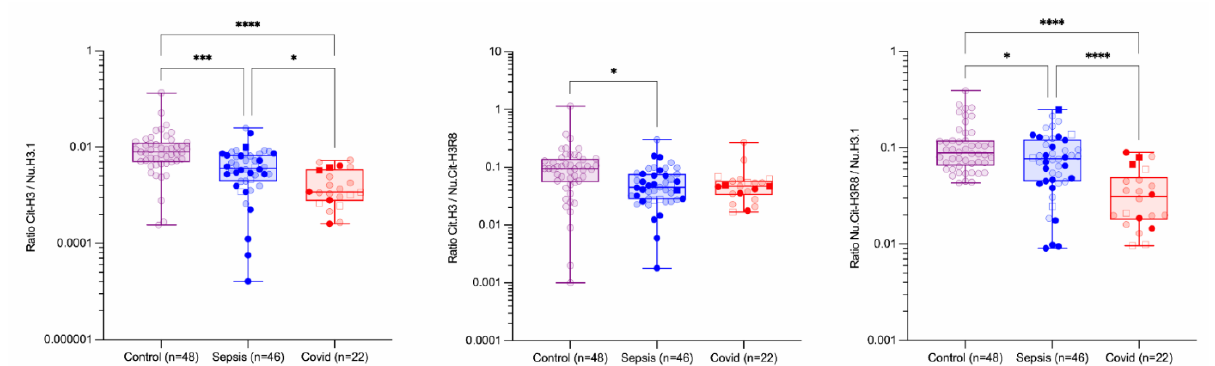
Figure 2. Ratio of circulating nucleosomes and neutrophil activation parameters in control, septic shock and critical COVID-19 subjects. The following ratios were proposed: (i) ratio of Cit-H3 on Nu.H3.1, (ii) ratio of Cit-H3 (citrullinated in R2, R8 and R17) on Nu.Cit-H3R8 and (iii) ratio of Nu.Cit-H3R8 on Nu.H3.1. Boxes represent 25th – 75th percentile with median. Whiskers represent min to max variation. Squares represent patients with a thromboembolic event, and non-transparent symbols represent dead patients. *, *** and **** represent p -values ≤ 0.05, ≤ 0.001 and ≤ 0.0001, respectively. Only differences that are statistically significant are reported. Abbreviations: Cit-H3, citrullinated histone H3 (citrullinated in R2, R8 and R17); Nu.Cit-H3R8, citrullinated H3R8-nucleosome; Nu.H3.1, H3.1-nucleosome. Table 1. Comparison of NETs’ formation markers in survivors and non-survivors. Results were reported as median (10th–90th percentile). Differences between groups were assessed using an unpaired t -test on log transformed data.